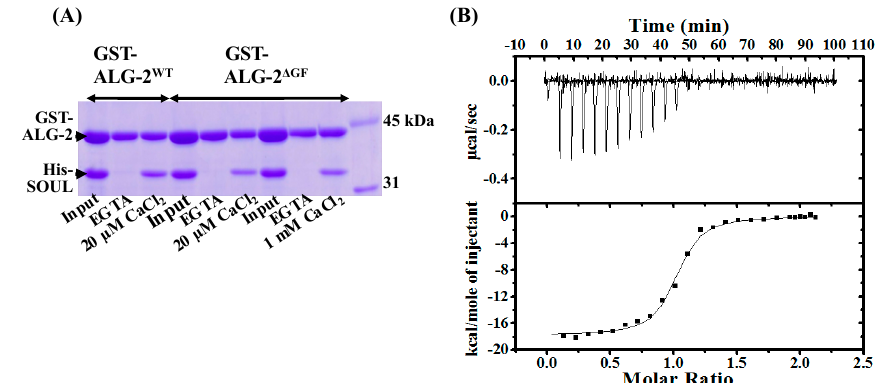
Figure 5. Interaction between SOUL WT and ALG-2 ∆ GF . ( A ) GST-pulldown assays using His-SOUL (5 µM) and GST-ALG-2 ∆ GF (5 µM) proteins under the same conditions as described in Figure 3C. ( B ) The typical isothermal titration calorimetric profiles of the interaction between His-SOUL WT and delta3-23ALG-2 ∆ GF in the presence of 15 µM Ca 2+ at 25 °C and pH 7.5.